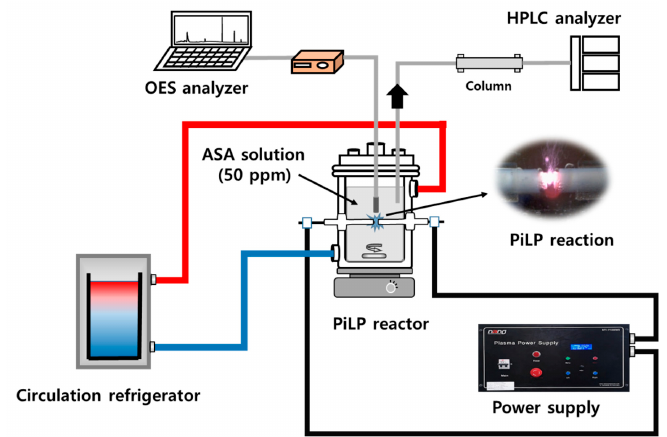
Figure 7. Schematic of the PiLP system for degradation of ASA.